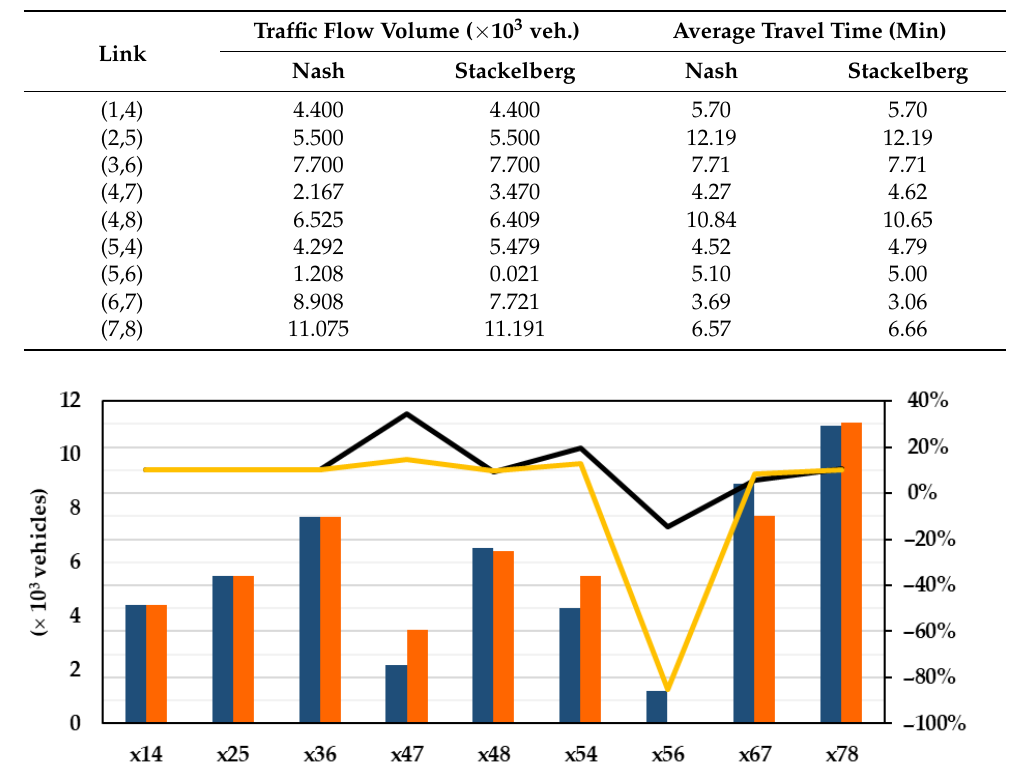
Table 10. Results of optimization with the Nash and Stackelberg approaches for road network links in scenario